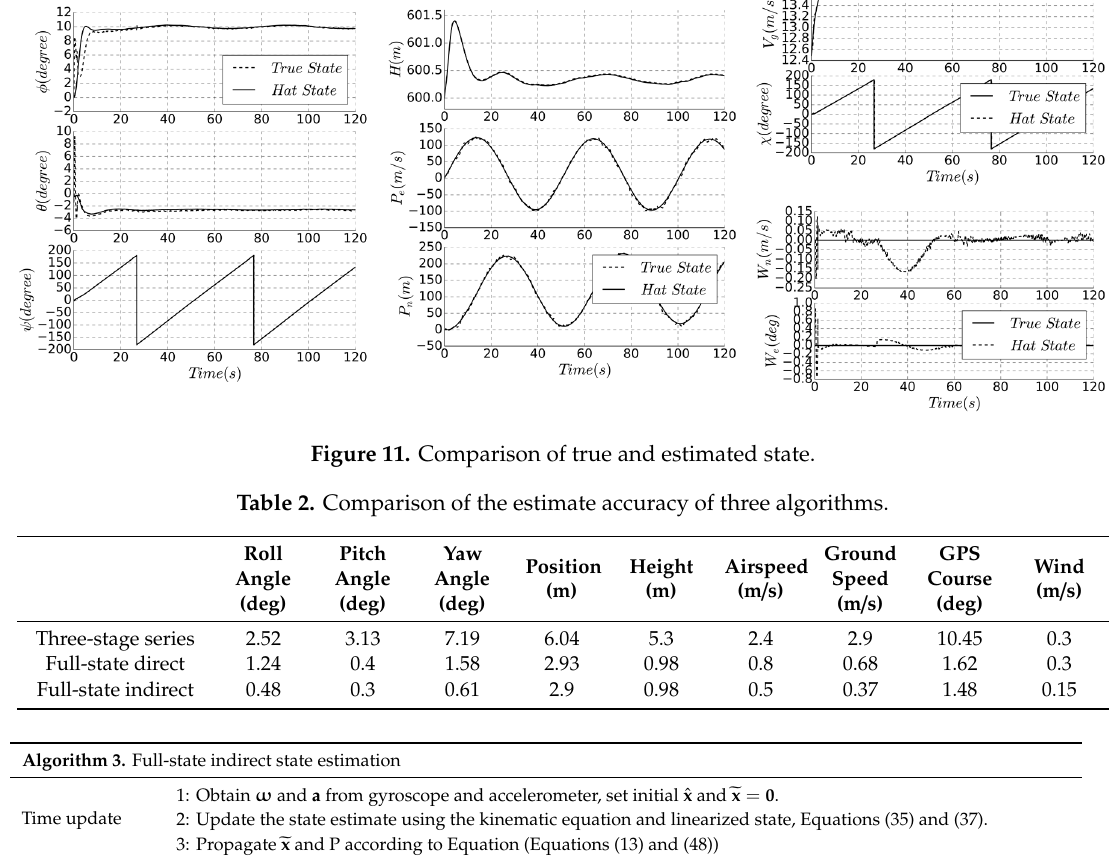
Algorithm 3. Full ‐ state indirect state estimation